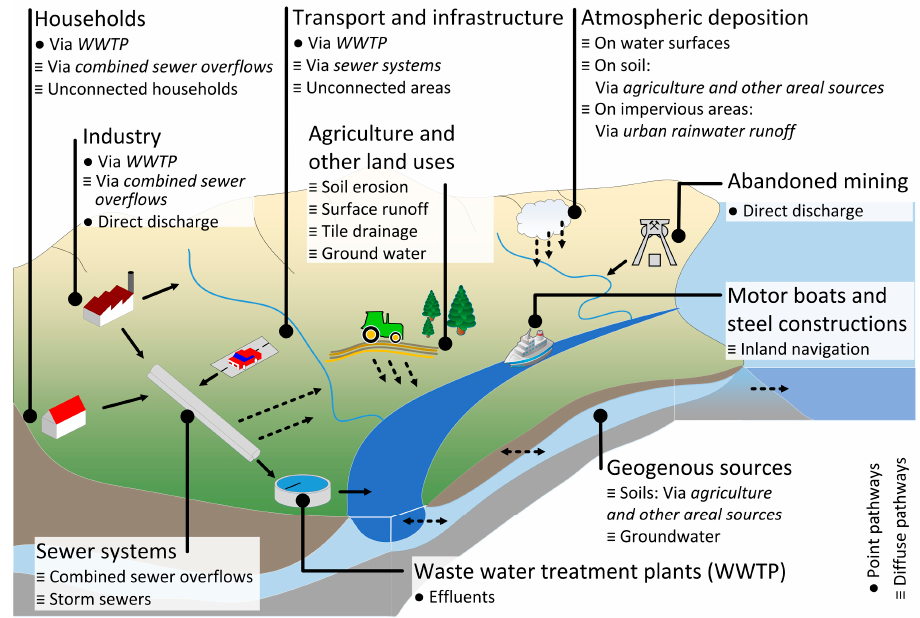
Figure 1. Substance emission pathways of current MoRE applications, arranged by source type (large print). Solid and dashed arrows denote direct and diffuse emissions, respectively. WWTP: waste water treatment plants.